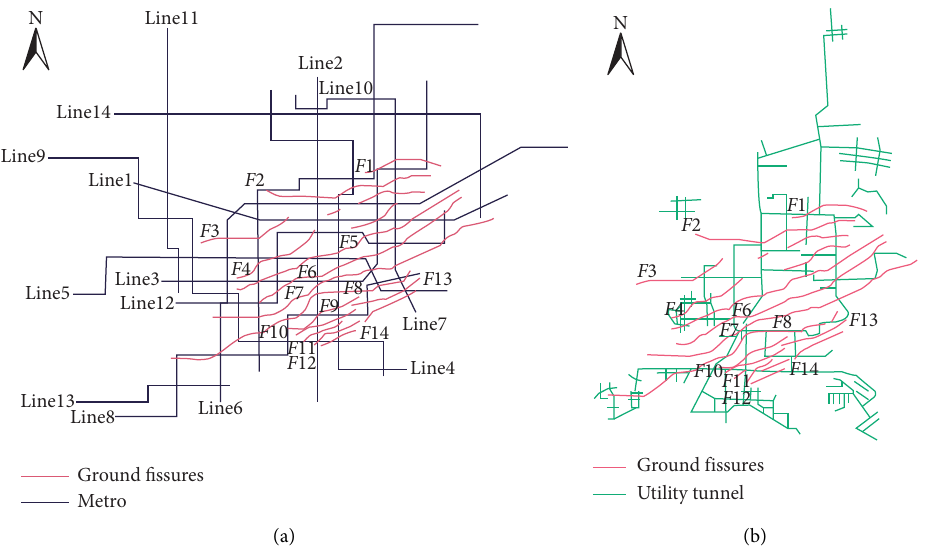
Figure 2: (a) Distribution of ground fissures and the metro planning network in Xi’an city. (b) Distribution of ground fissures and the utility tunnel network in Xi’an